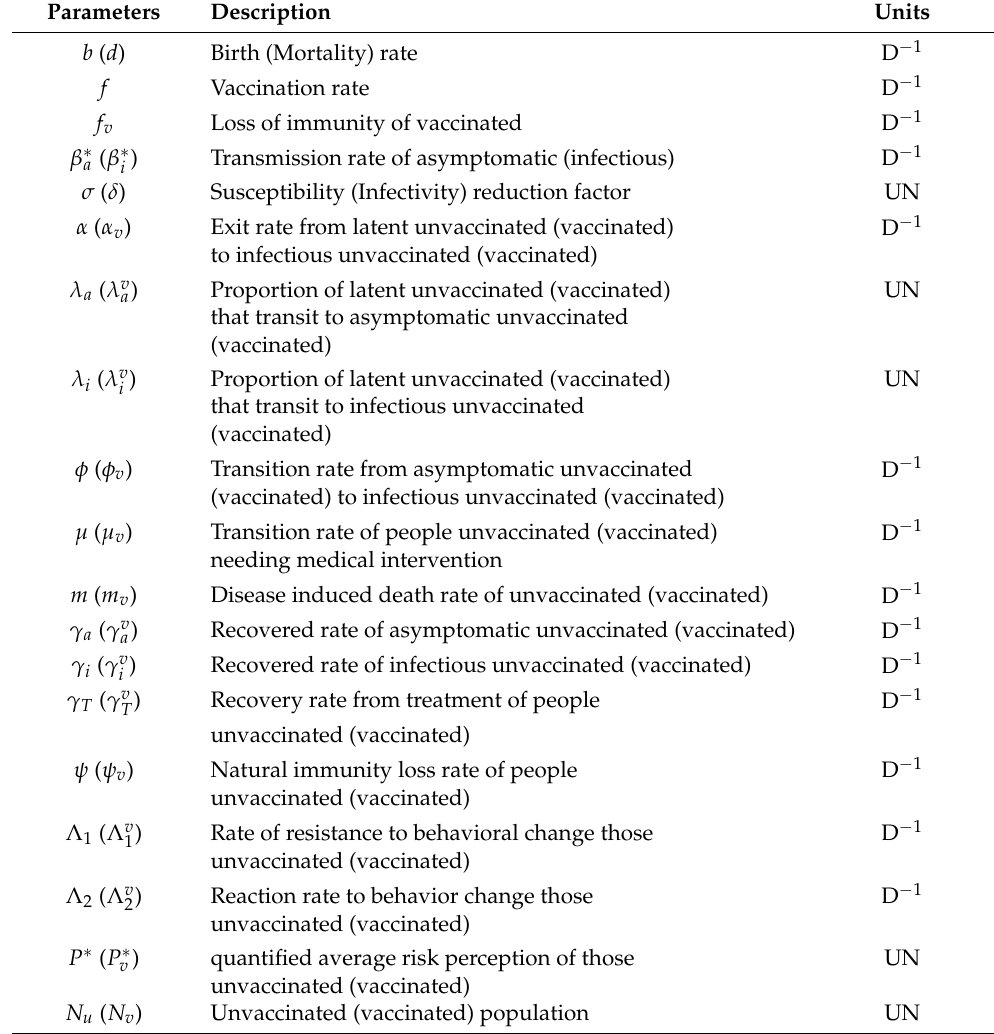
Table 2. Description of parameters and parameter values related to behavior. D = days, UN = unitless. N = N u + N v . In order to not discriminate between people with different beliefs and attitudes towards vaccination, we used the same numeric values for both P ∗ and P ∗ v . ∗ The detail of the referenced values is presented in the Appendix A, Table